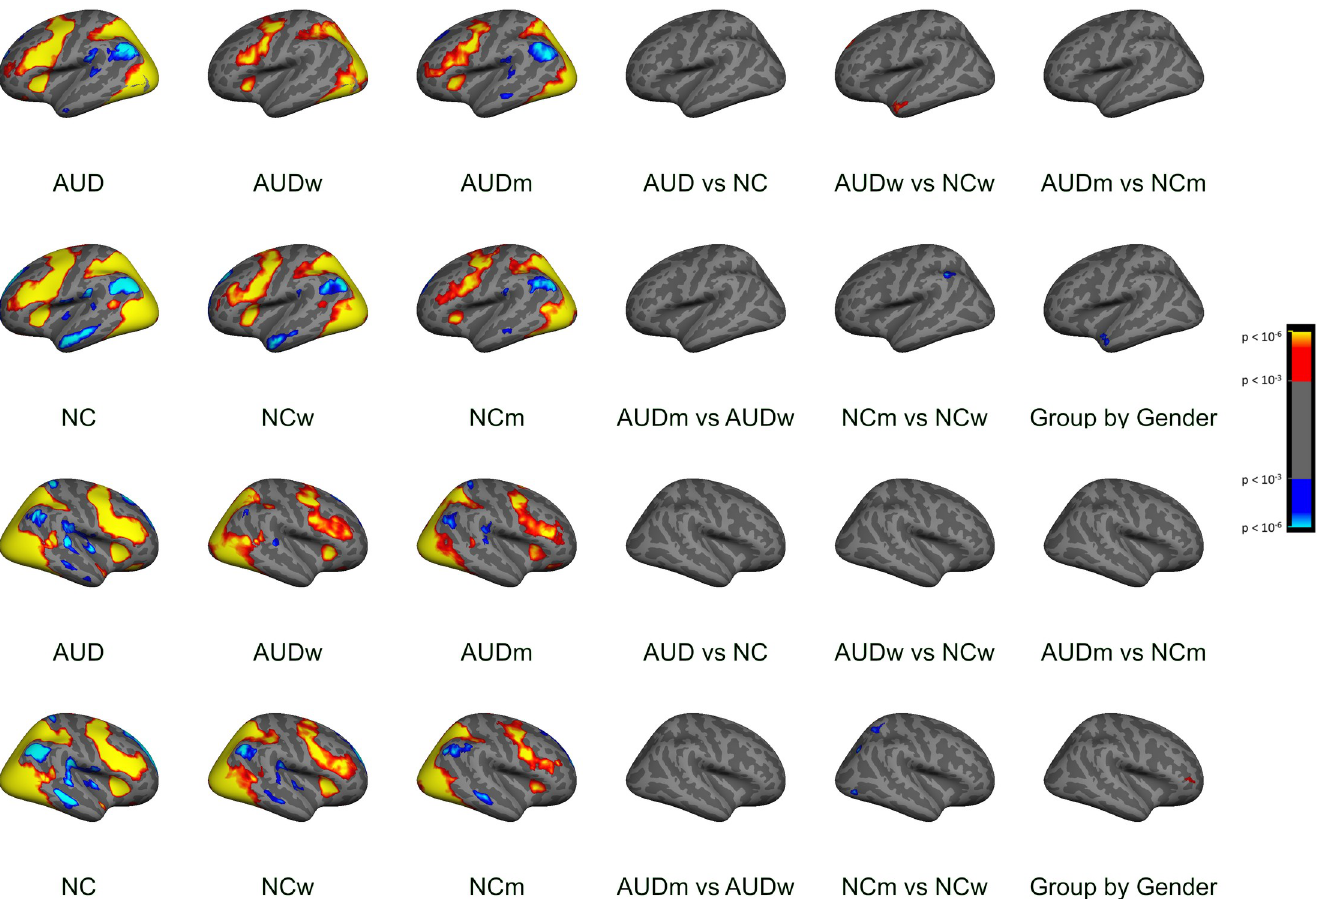
Fig 2. Cortical surface cluster maps: Positive vs. fixation, lateral. The left three columns show group maps, and the right three columns show group comparisons. The top two rows represent the left hemisphere, and the bottom two rows represent the right hemisphere. The clusters in this figure had a vertex wise threshold of p < .001 with a minimum cluster size of 100 mm 2 . This can result in more clusters being visible than are listed in Table 3 and S1 Table, wherein numbers were derived using permutation testing (cluster threshold p < .05, further corrected for analyses of left, right, and volume spaces).